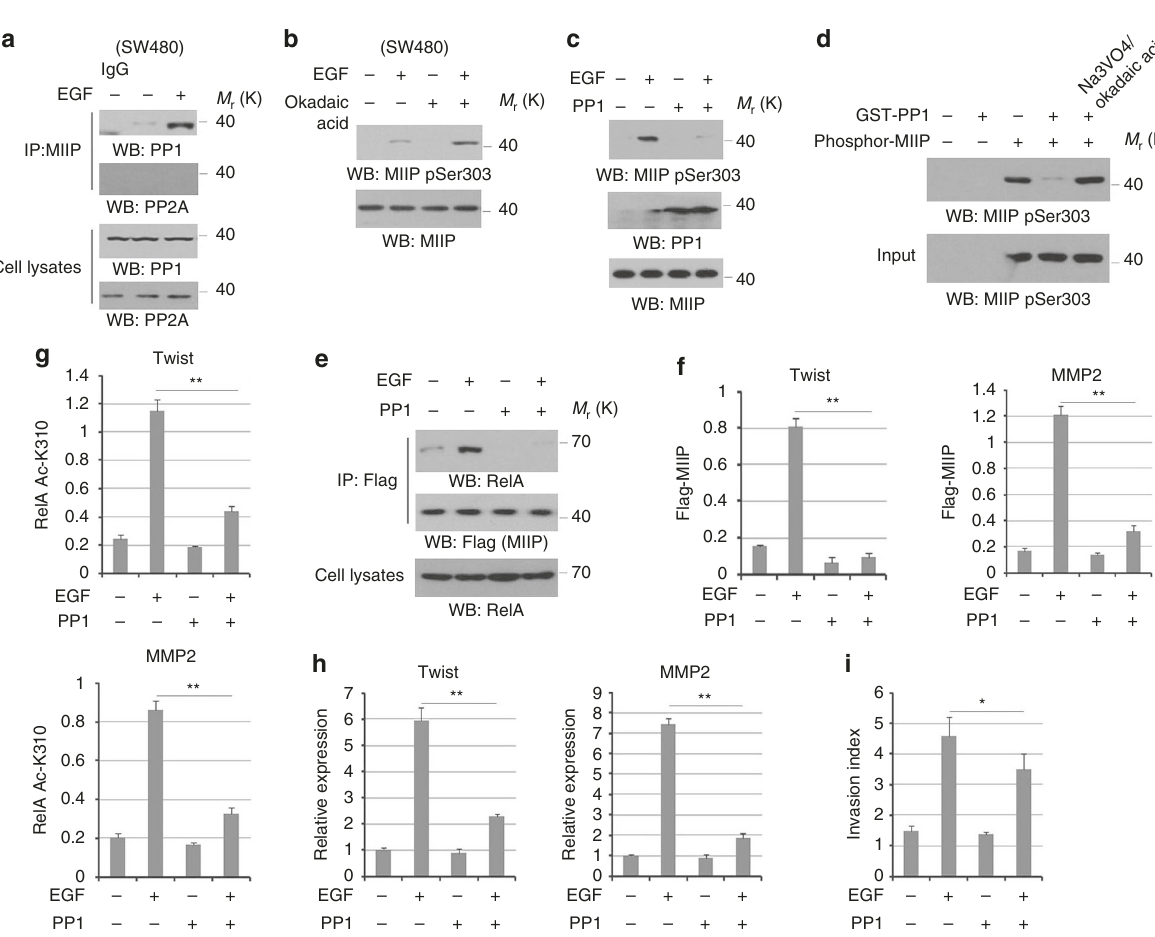
acetylation (Supplementary Fig. 3e) and MIIP enrichment at promoters (Supplementary Fig. 3f), and MMP2 and Twist expression levels (Supplementary Fig. 3g).